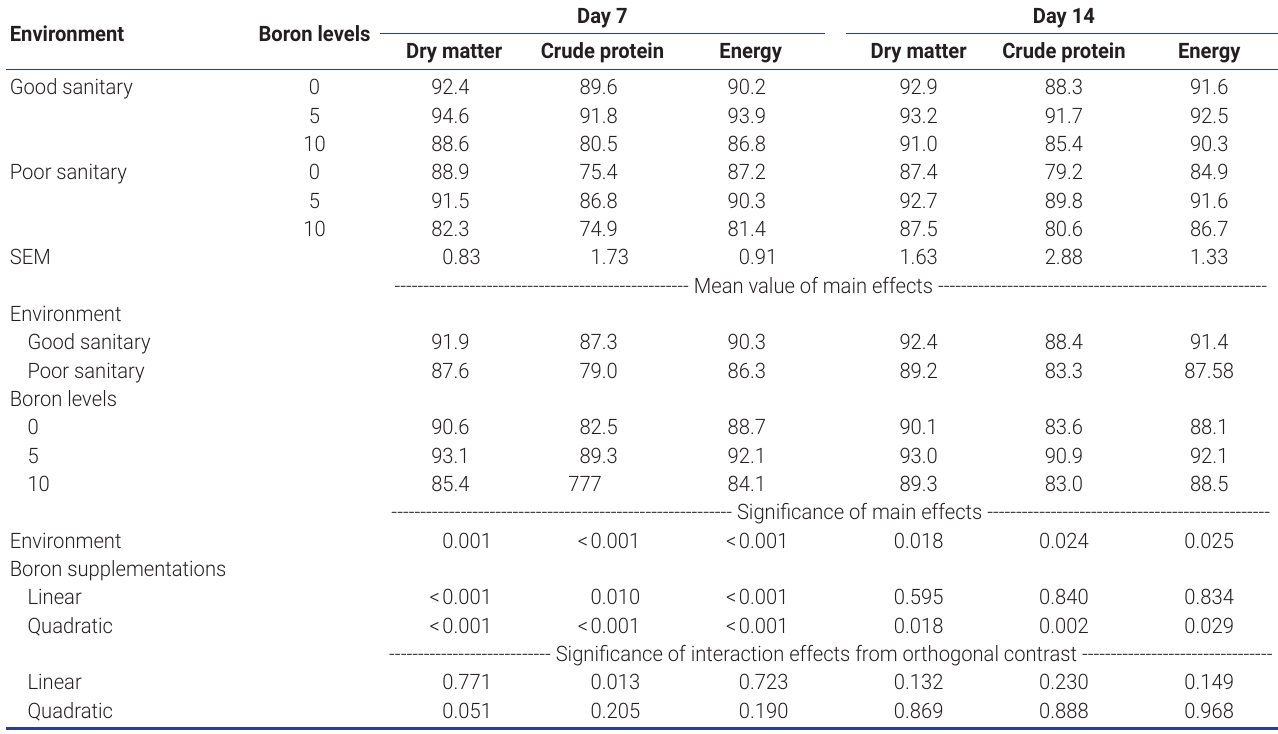
Table 4. Effects of environment and boron levels (mg/kg) on apparent total tract digestibility (%) of nutrients in weaned pigs on days 7 and 14 Environment